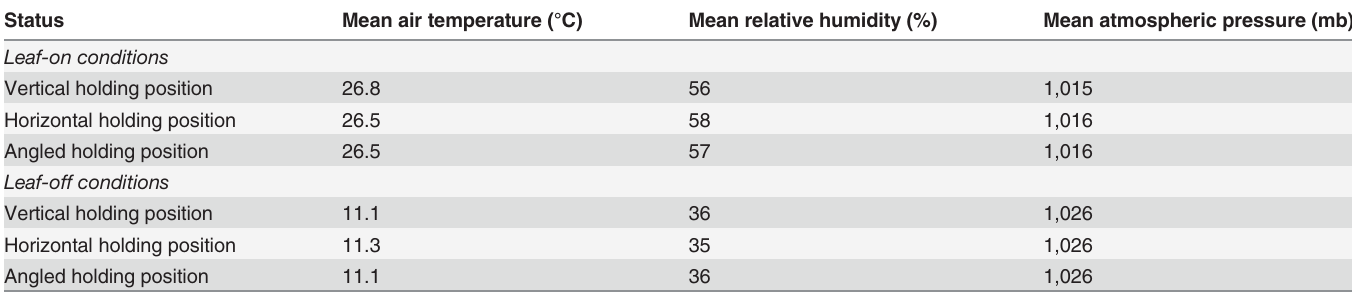
Table 4. Mean environmental conditions during data collection with the Flint GNSS receiver in the coniferous